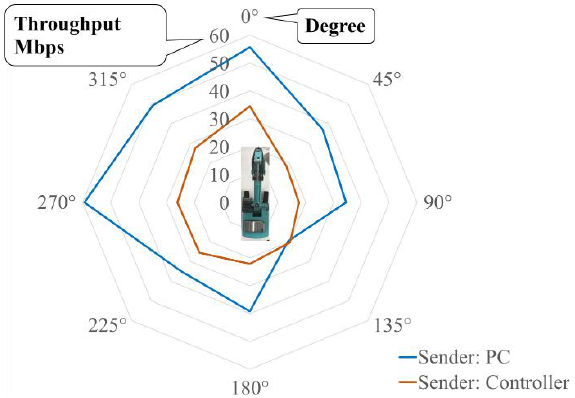
Figure 12. Average UDP throughput in each communication distance: The black bar is the results when the PC is the sender, and the white bar is results when the communication controller is the sender.